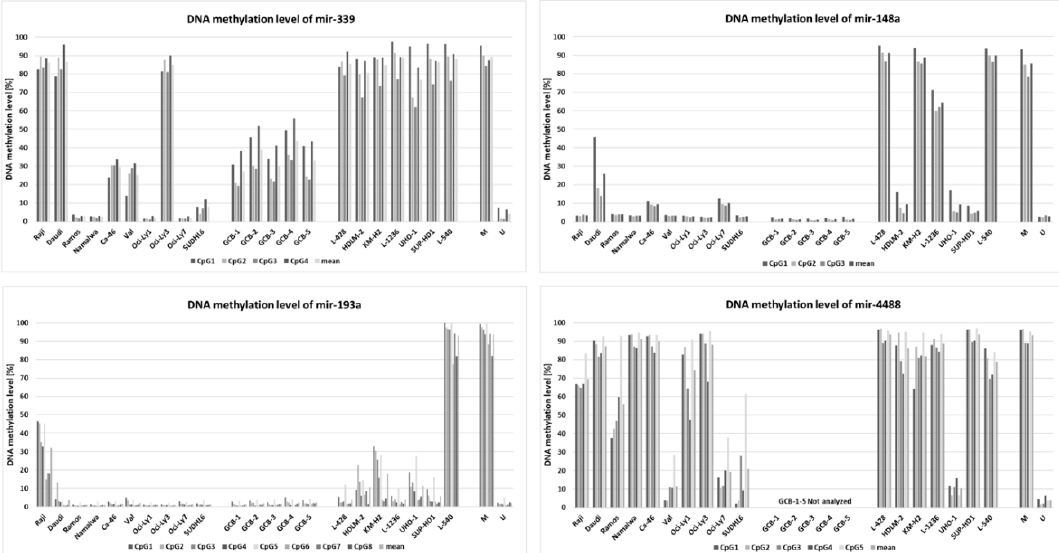
Figure 2. DNA methylation level of promoter regions of downregulated miRNAs (mir-339, mir-148a, mir-193a and mir-4488) in cHL cell lines ( n = 7), NHL cell lines ( n = 10) and GCB 77 + from tonsillectomy specimens of chronic hyperplastic tonsillitis ( n = 5) (except mir-4488) (analyzed by DNA bisulfite pyrosequencing).